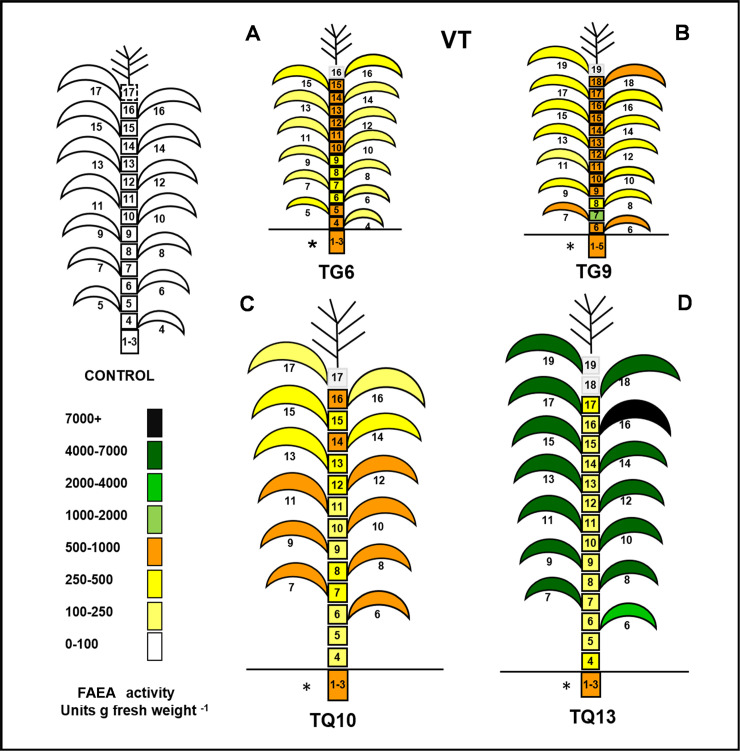
Comparison of overall FAEA activity in individual leaves and internodes of TG and TQ plants at VT stage of development.FAEA activity in leaves and internodes at VT developmental stage for TG6, TG9 and TQ10 and TQ13. * indicates the fused internodes 1–3 and dotted lines refer to no data internodes.